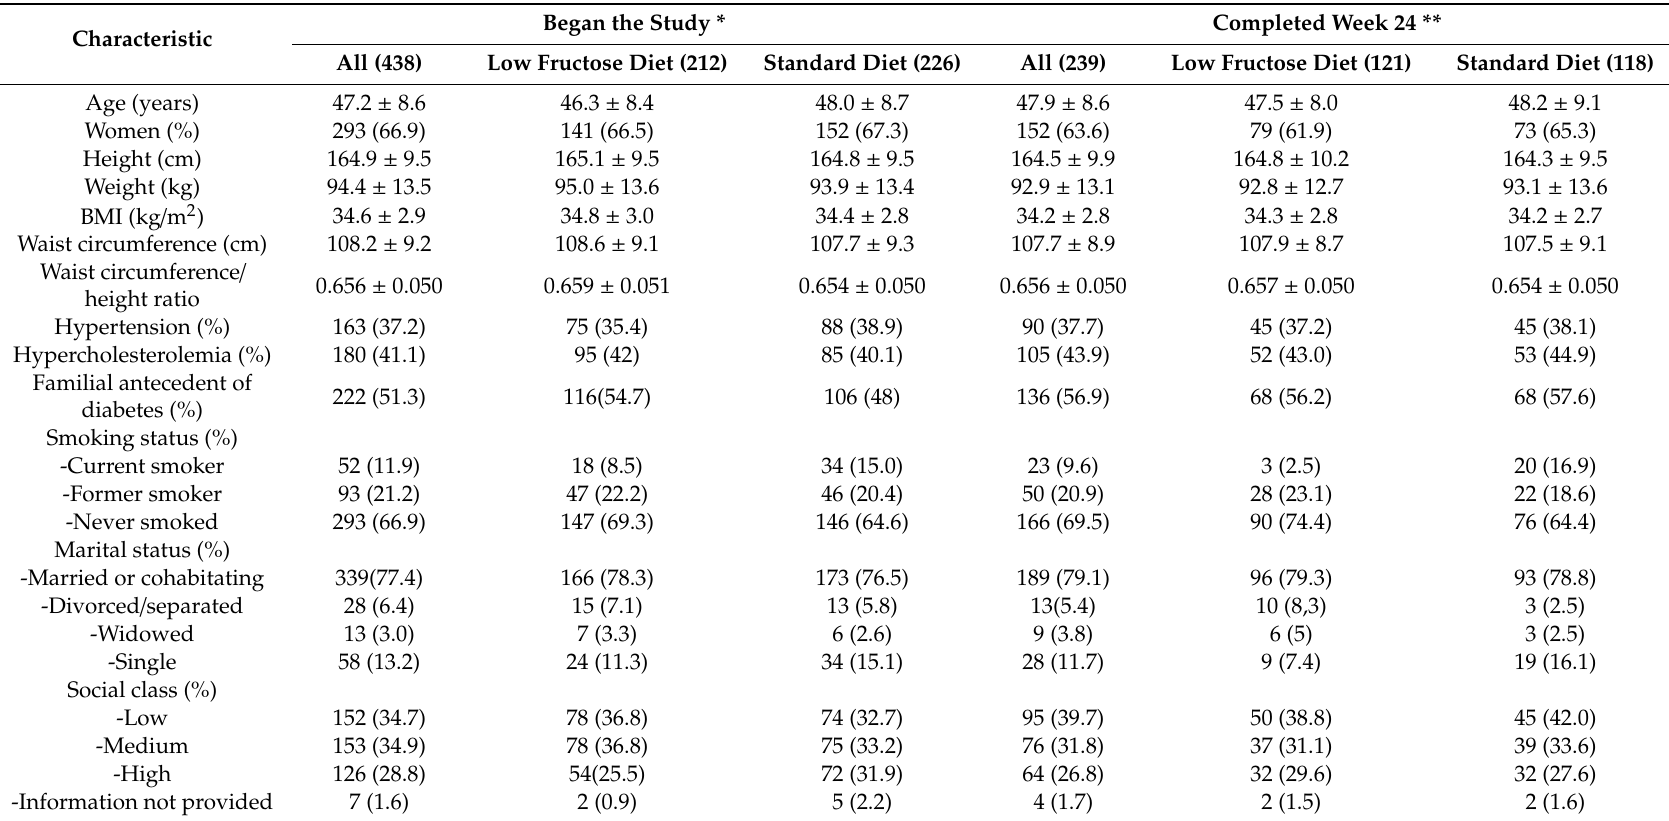
Table 1. Baseline Characteristics of the Study